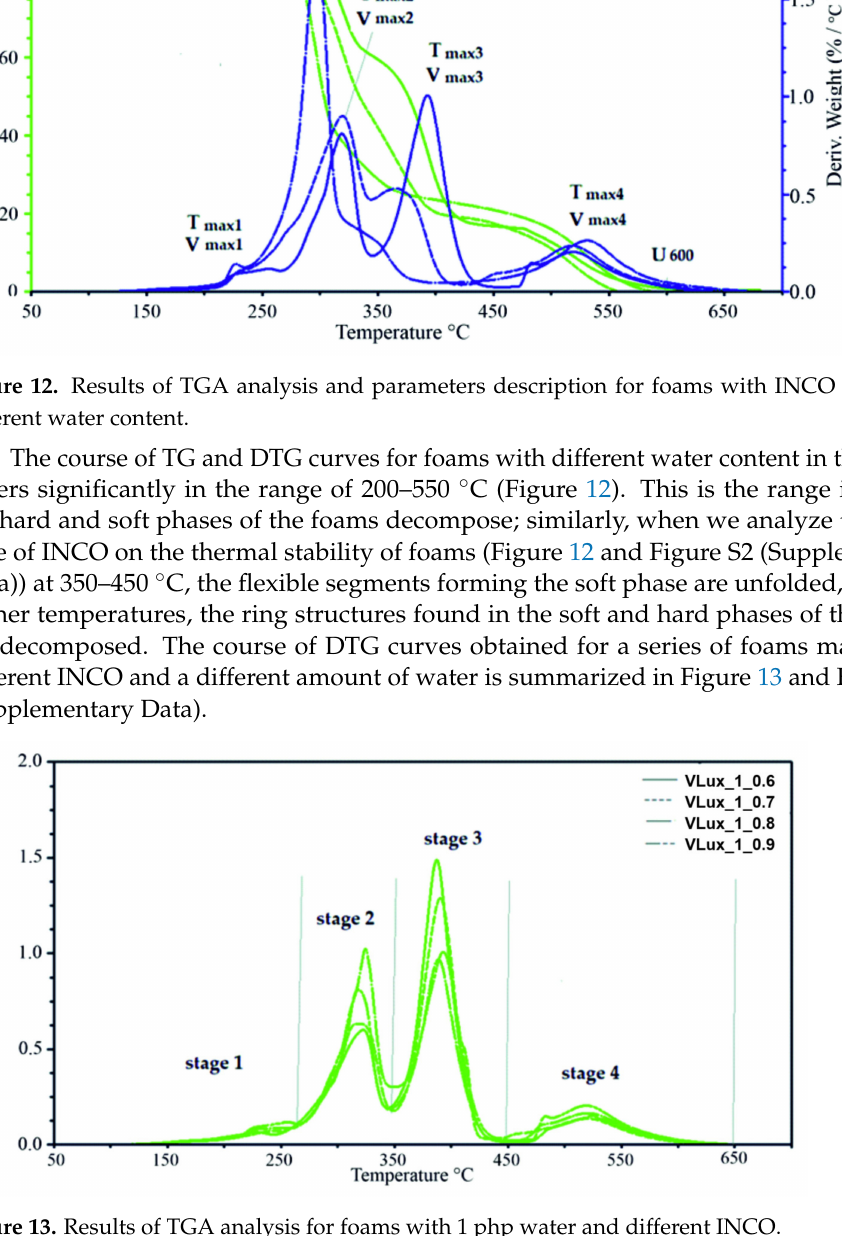
Figure 13. Results of TGA analysis for foams with 1 php water and different